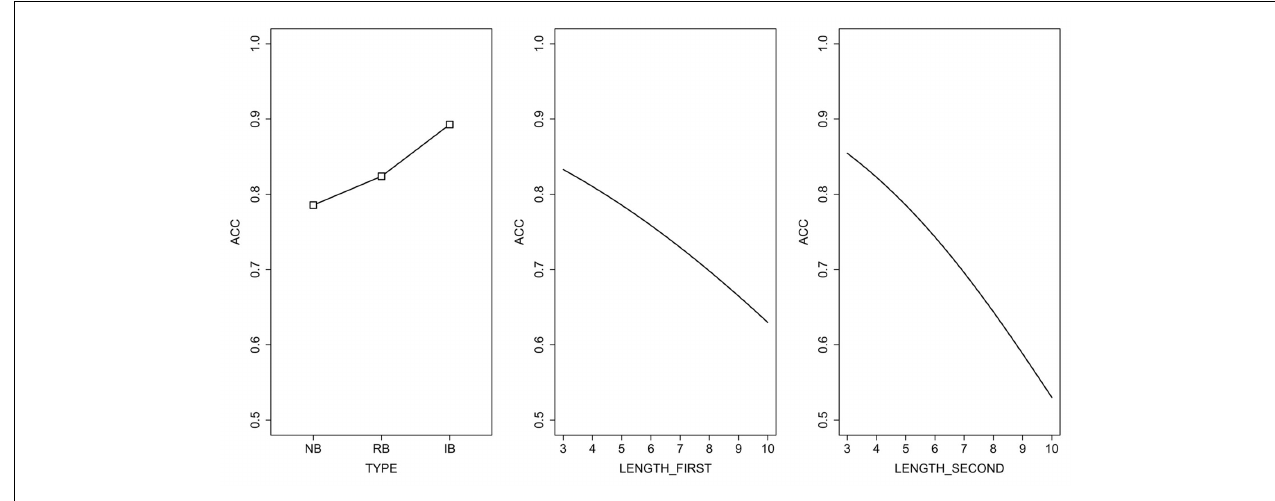
FIGURE 2 | Partial effects of model fit on all stimuli. The plots are shown for the reference level of factor and adjusted for the median value for the